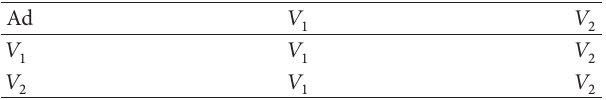
Table 6: Adjoint table of the Lie algebra of (2.4) . Ad